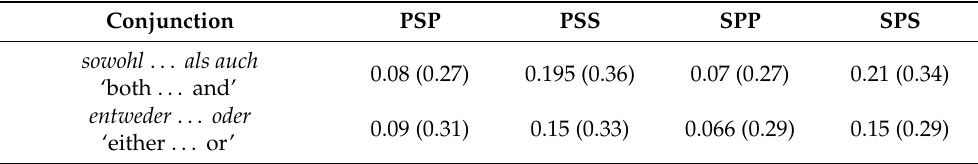
Table 10. Mean residual reading times at the critical verb across conditions, Experiment 3 (S = singular, P = plural).